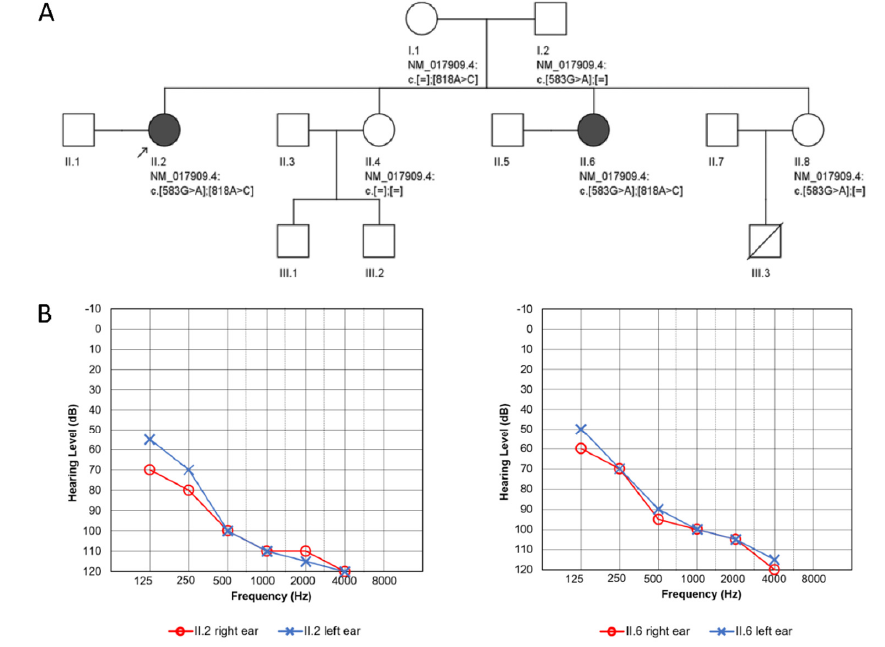
Figure 1. Pedigree and audiological data of the investigated family. ( A ) Pedigree showing a ff ected family members (proband II.2, proband’s sister II.6) and the identified RMND1 variants. ( B ) Pure tone audiometry results of the proband (left panel) and her sister (right panel) at the age of